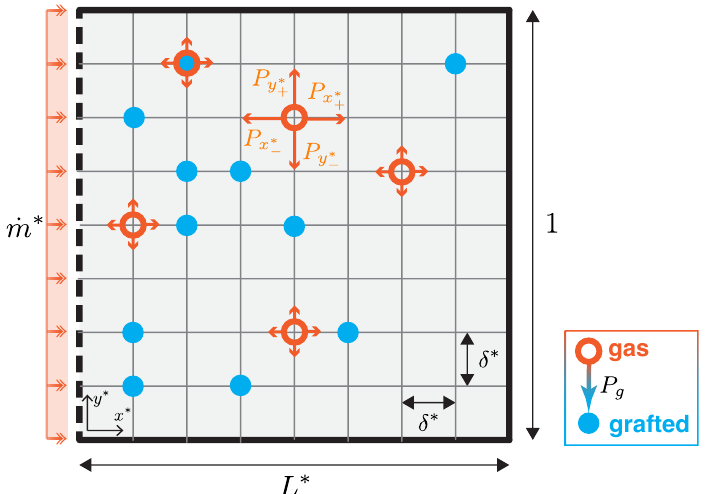
Figure 2. Schematic of 2D domain for Monte Carlo simulation. Particles enter uniformly at x ∗ = 0 with flux ˙ m ∗ and undertake a symmetric random walk on a 2D lattice with step-size ∆ x ∗ = ∆ y ∗ = δ ∗ = P = P = P = 1/4. At each time step, the particles have a probability P g and probability P x ∗ x ∗ − y ∗ + y ∗ − + of irreversibly grafting in place. Only one particle is allowed to graft at each grid